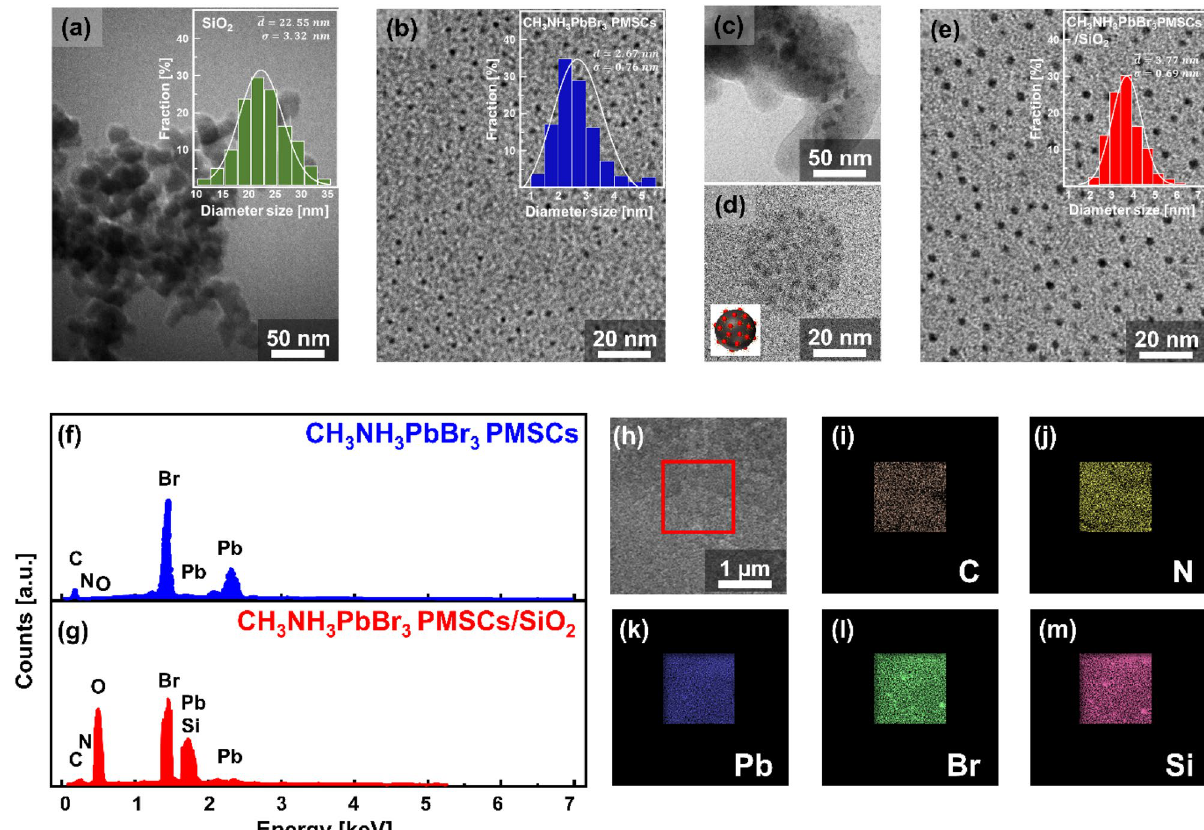
Figure 3. TEM images and its corresponded size distribution of the ( a ) SiO 2 , ( b ) CH 3 NH 3 PbBr 3 PMSCs, ( c – e ) CH 3 NH 3 PbBr 3 PMSCs/SiO 2 . EDS spectra of the ( f ) CH 3 NH 3 PbBr 3 PMSCs, ( g ) the CH 3 NH 3 PbBr 3 PMSCs/SiO 2 . ( h – m ) EDS mapping analysis of the CH 3 NH 3 PbBr 3 PMSCs/SiO 2 showing the elemental distribution of carbon, nitrogen, lead, bromine, and silicon,